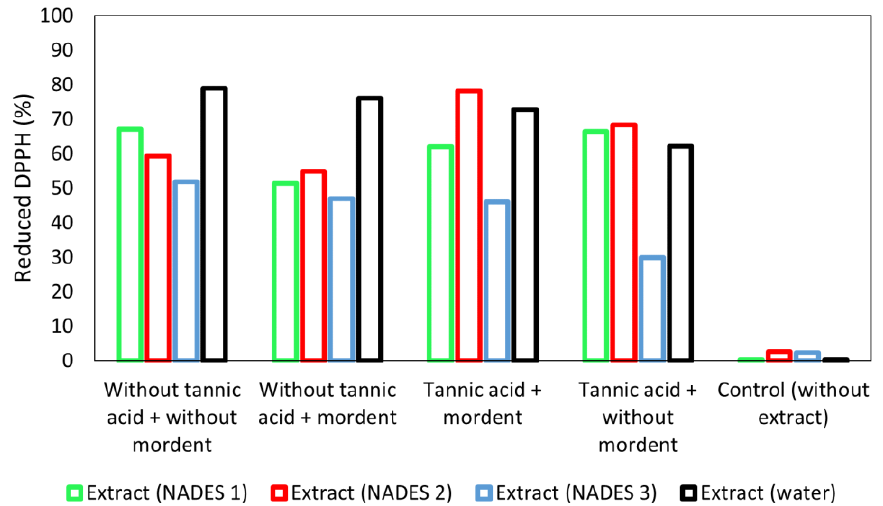
Figure 10. %DPPH reduced by fabrics dyed with cork extracts extracted with NADES 1, 2, 3, and water. Controls are fabrics pre-treated only with the NADES and